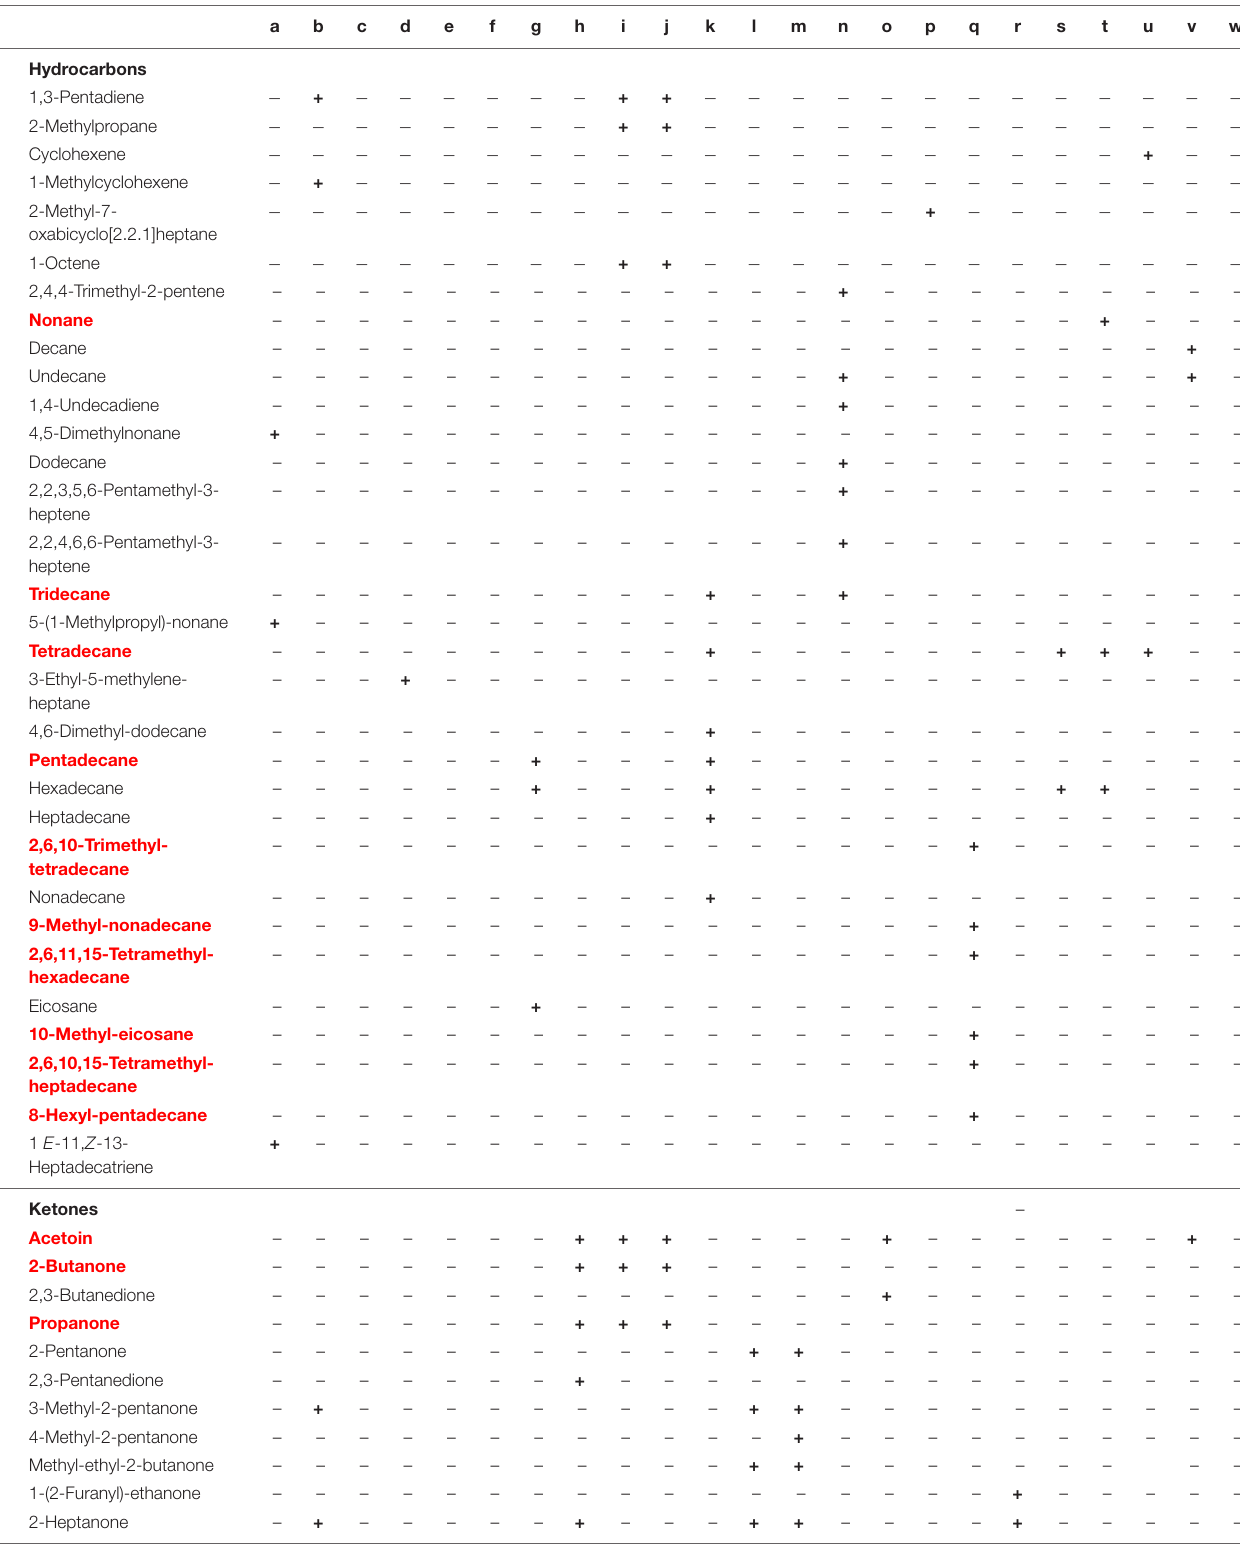
TABLE 2 | Volatile secondary metabolites emitted by B. subtilis isolates a: 8133, 8114, 2274; b: n.d.; c: CF3; d: NCTC 10073; e: M29; f: SYST2; g: FA26; h: SV75-1; i: SV44-2; j: SV36-2; k: G-1; l: XF-1; m: 168; n: 8B-1; o: PPCB001; p: BL02; q: JA, r: G 8 ; s: 7; t: 8; u: 9; v: 168; w: 6051. a